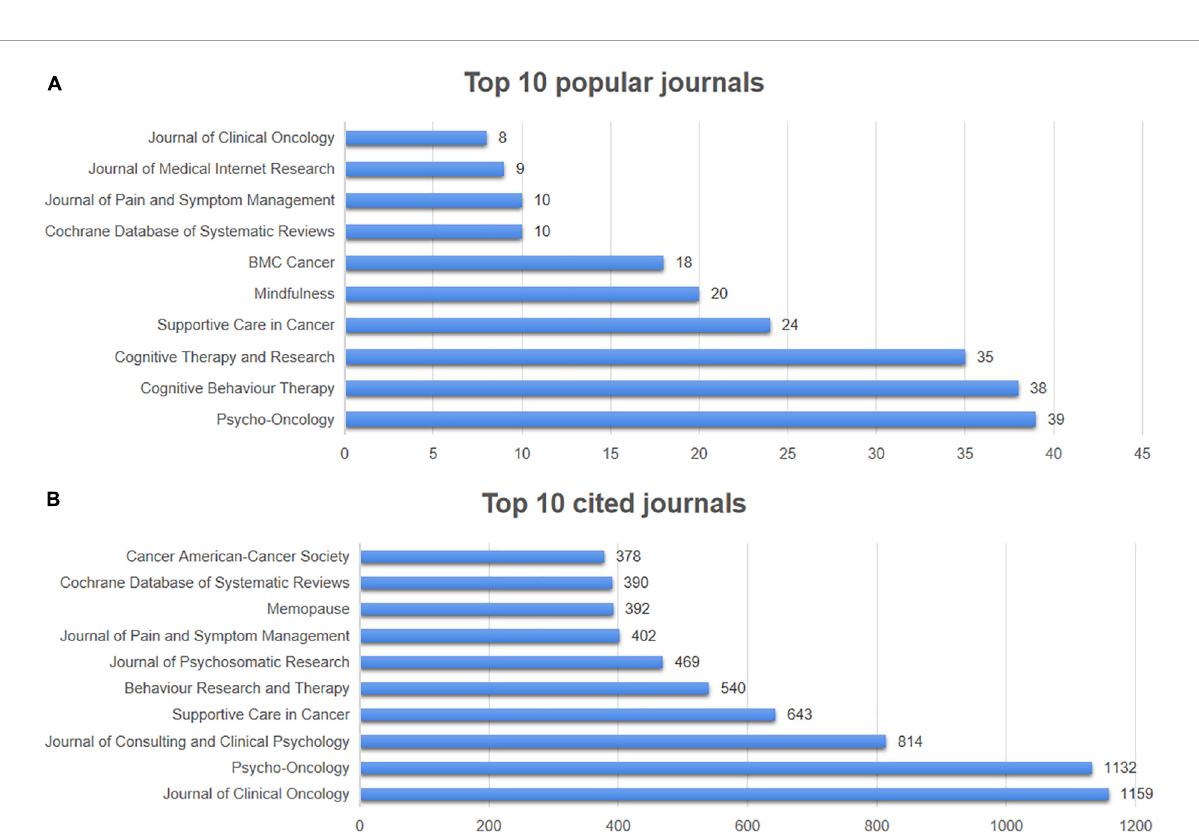
FIGURE6 Top 10 popular journals and cited journals. (A) Top 10 popular journals regarding the number of related articles. (B) Top 10 popular journals regarding the number of